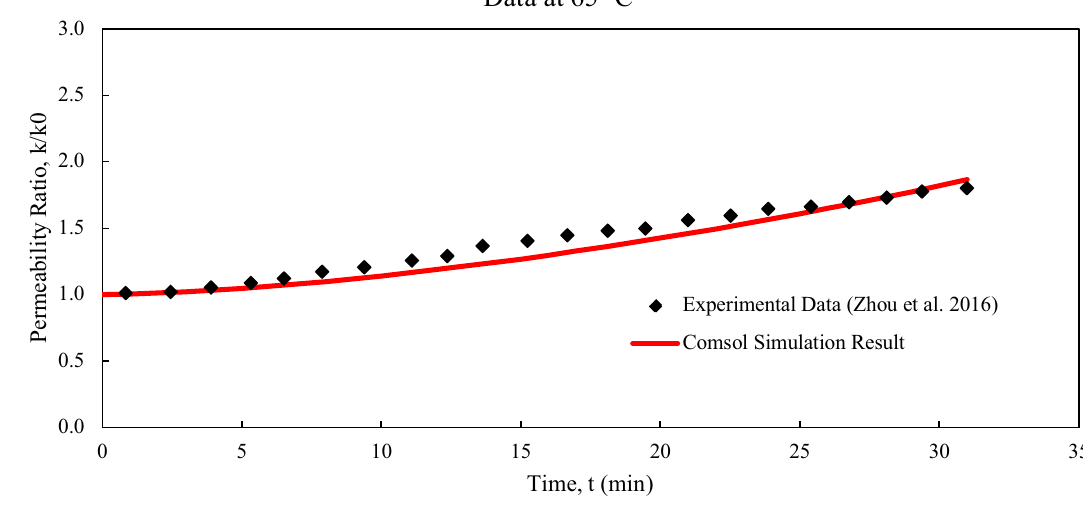
Fig. 3 Plot of comparison between fluoroboric acidizing simulation result and experimental data at 65